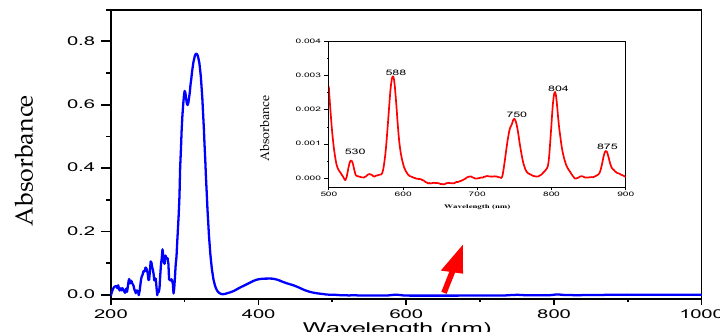
Figure 1. UV–visible spectra of concentrated DMF solution of Lc .